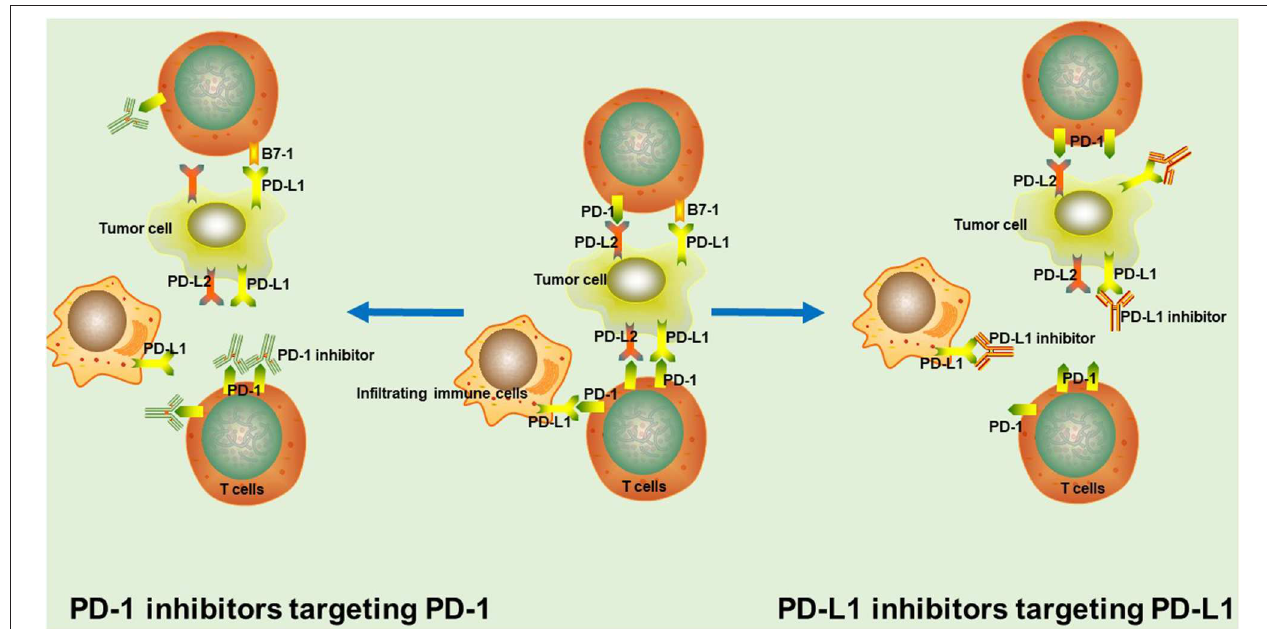
FIGURE 1 | The rationale of PD-1/PD-L1 inhibitors. In tumor tissue, PD-1 interacts with PD-L1 or PD-L2 to mediate significant immune suppression. PD-1/PD-L1 inhibitors binds to corresponding target, thus blocking the PD-1/PD-L1 signaling pathway and markedly enhancing T cell function and the anti-tumor immunity.